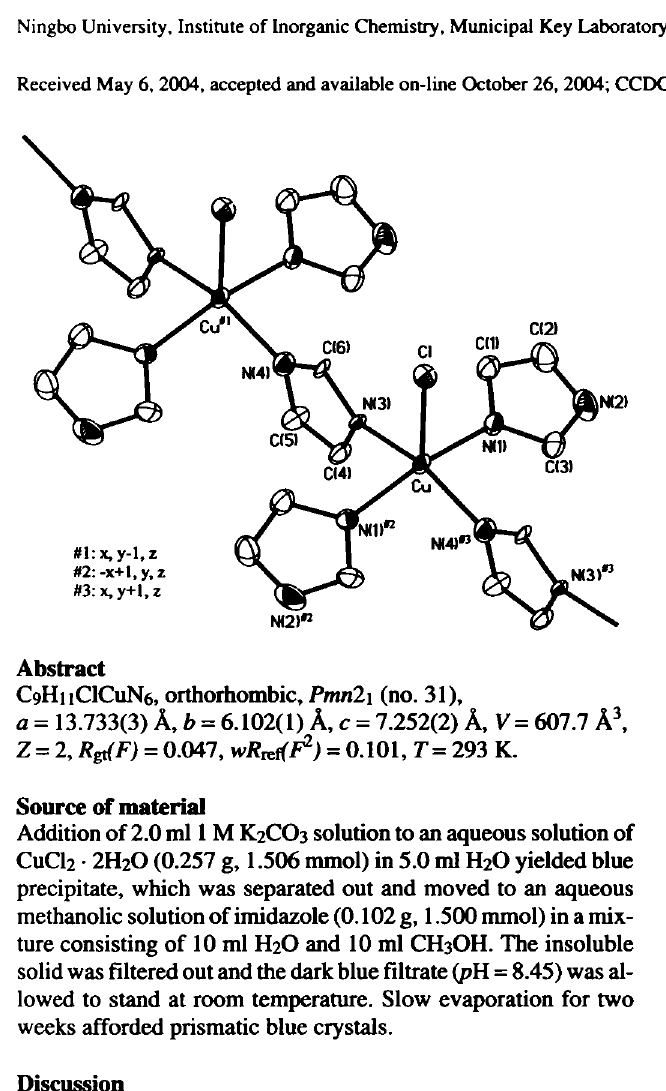
Table 2. Atomic coordinates and displacement parameters (in A 2